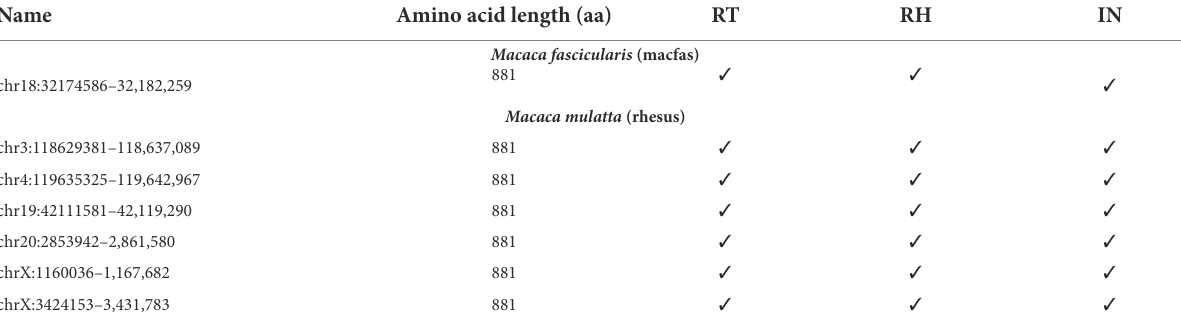
TABLE 4 Presence of structural and functional domains in the potential pol